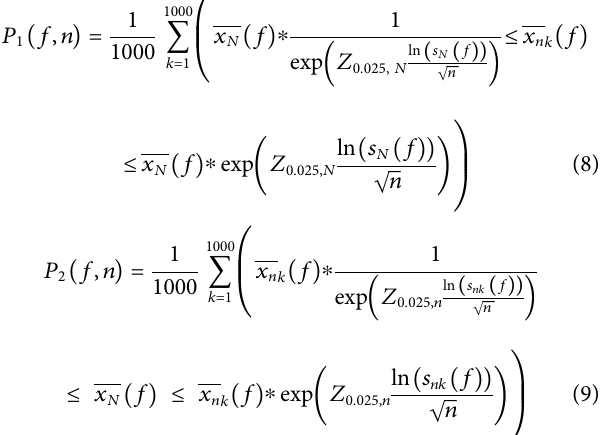
Frontiers in Earth Science |